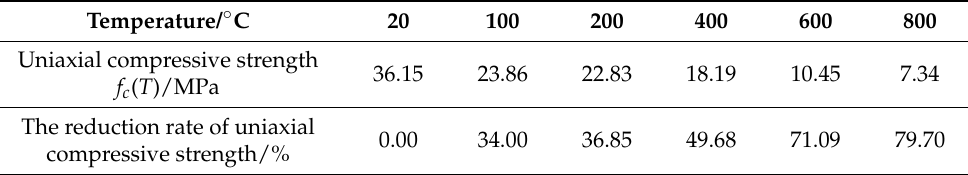
Table 4. Uniaxial compressive strength and the reduction rate of uniaxial compressive strength.